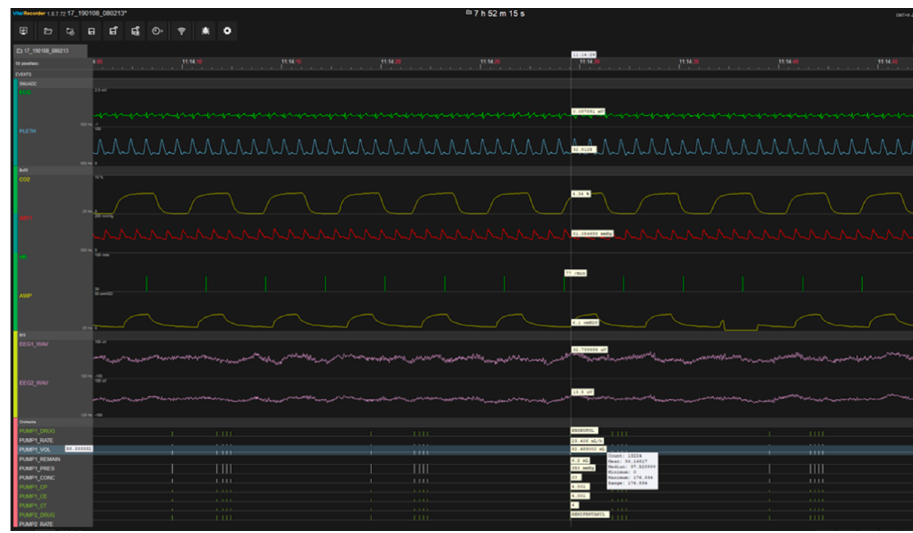
Figure 1. Vital Figure 1. Vital Recorder. Table 2. Data description.